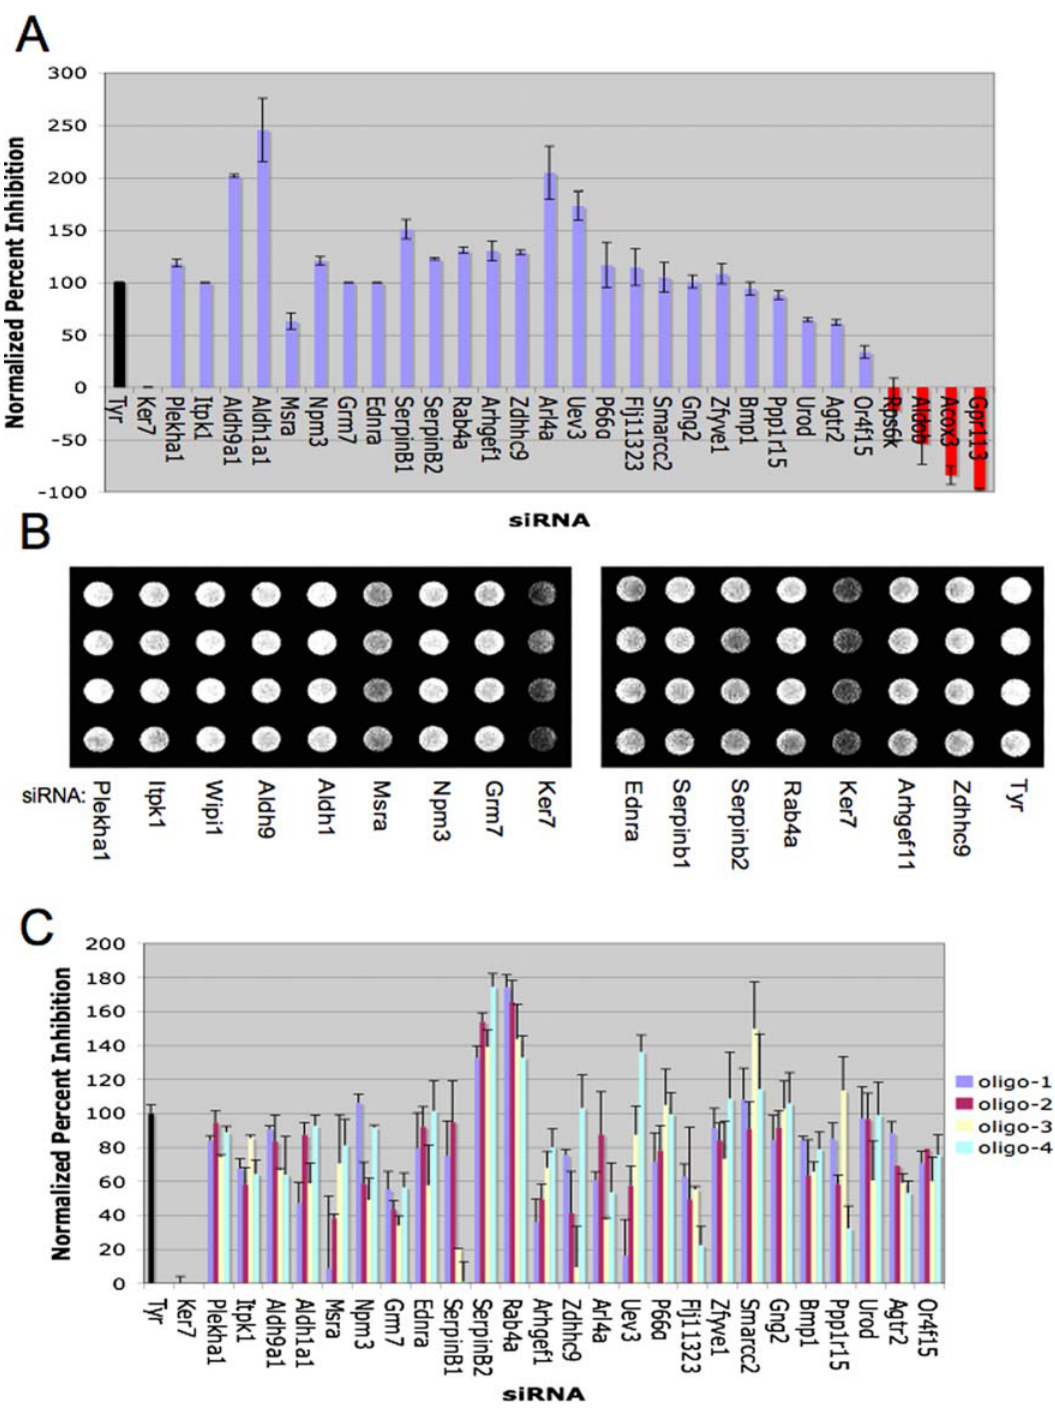
Figure 1. Validation of novel gene products supporting melanogensis. A) MNT-1 cells were transfected with the indicated siRNA pools (50 nM final concentration) targeting 35 of the 94 positive regulators of melanogenesis identified in the primary screen. siRNAs targeting Ker7, a gene that does not impact pigment production, were used as a negative control (black bar). A normalized percent inhibition calculation [26] was employed to compare the consequences of each siRNA pool on pigmentation with that observed upon depletion of tyrosinase. Bars represent mean and s.e.m. for n=3. Red bars indicate failure to significantly suppress pigmentation. The results of the analysis of these 35 genes are shown in this panel (those genes that were not putative autophagy regulators) and in Figure 3 (putative autophagy regulators). A summary of the results for all 35 genes is shown in Table S4. B) A light micrograph of a representative opaque-walled, clear-bottomed 96-well microtiter plate containing MNT-1 cell monolayers 7 days post transfection with the indicated siRNAs is shown. C) Four independent siRNAs targeting the indicated genes (see Table S3 for siRNA sequence information) were separately tested for the capacity to suppress pigmentation as in (A). Associated p-values (student’s t-test) are reported in Table